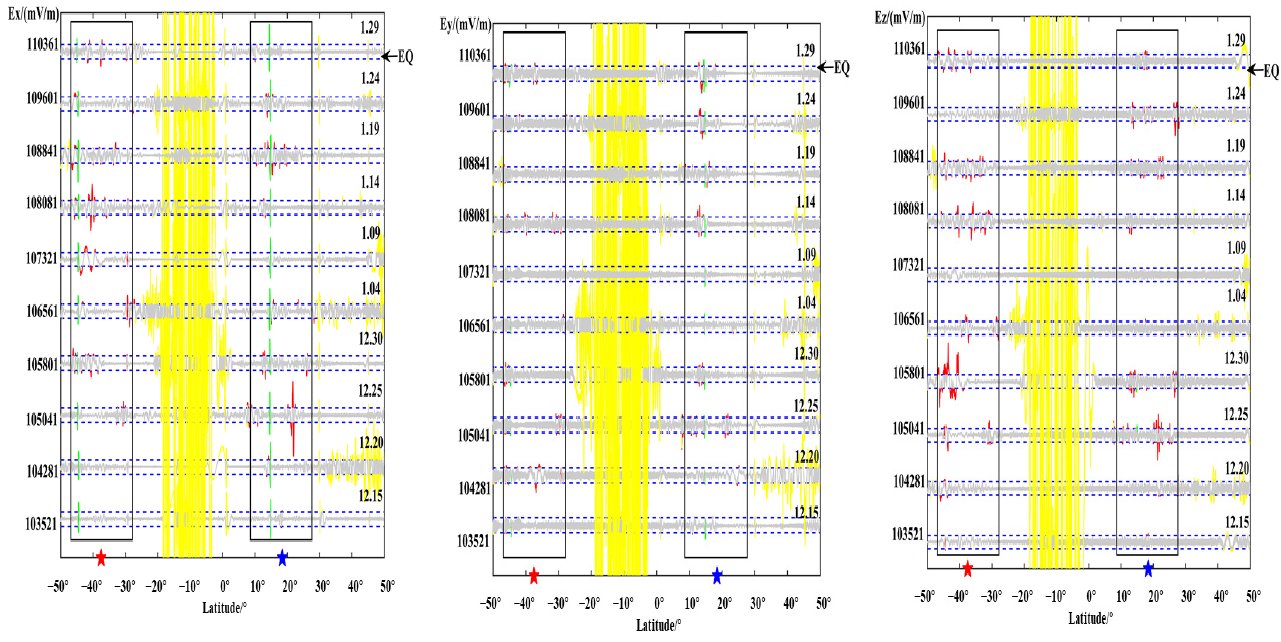
Figure 6. Orbit 109,601 and its revisited tracks (the red and blue five-pointed stars indicate the magnetic conjugate and epicenter positions, respectively, and the black frame indicates the seismogenic range where disturbance signals may exist, the horizontal blue dotted line is the threshold set according to the standard deviation of the electric field signal after reconstruction, respectively; the following figures same as here noted).